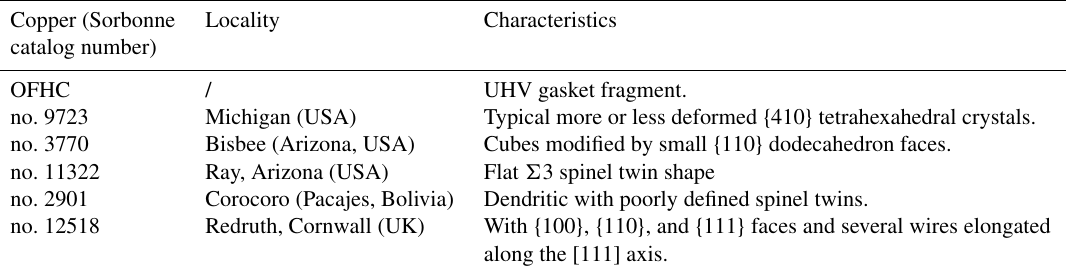
Table 2. List of the samples analyzed by NanoSIMS. Copper (Sorbonne Locality